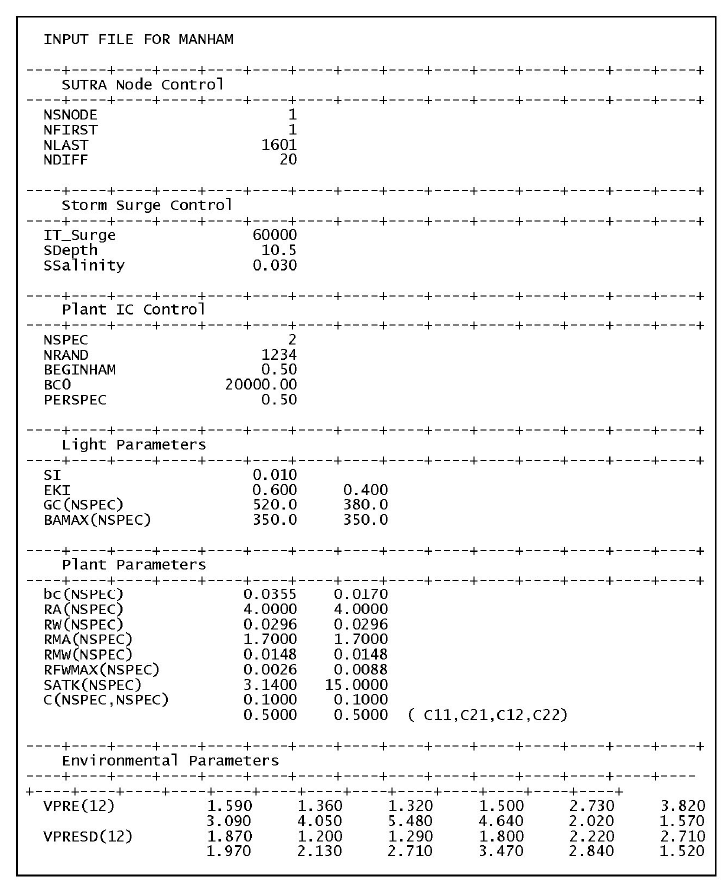
Figure A2.2. Example input file (MANHAM.DAT) for MANHAM module in MANTRA for the example case of Rowdy